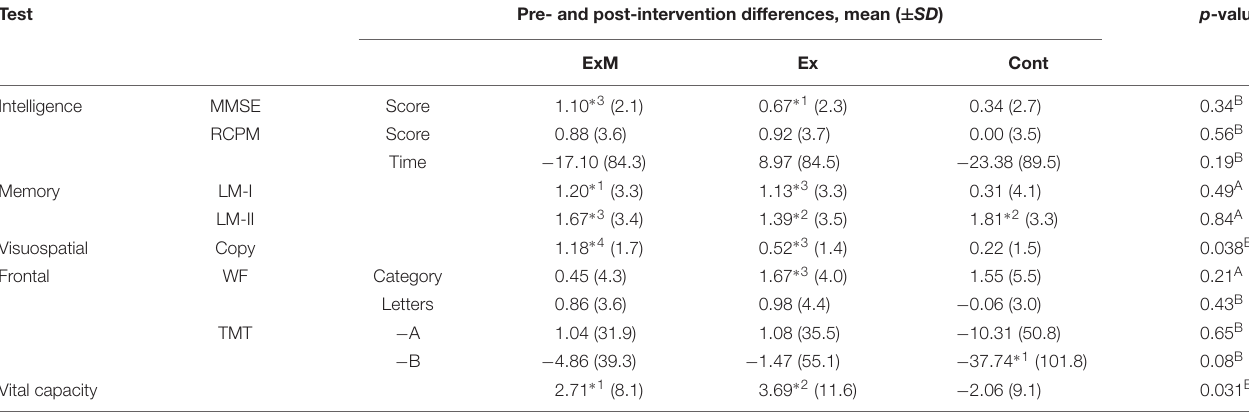
TABLE 2 | Neuropsychological and physiological assessment results before and after intervention. Test Pre- and post-intervention differences, mean ( ± SD ) p -value